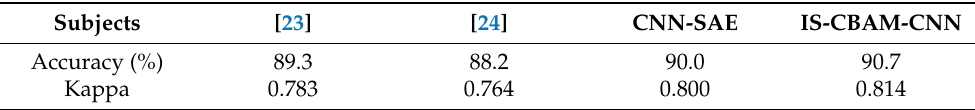
Table 3. Competition II dataset III accuracies (%) results for the winner algorithm [23], deep network [24], CNN-SAE and